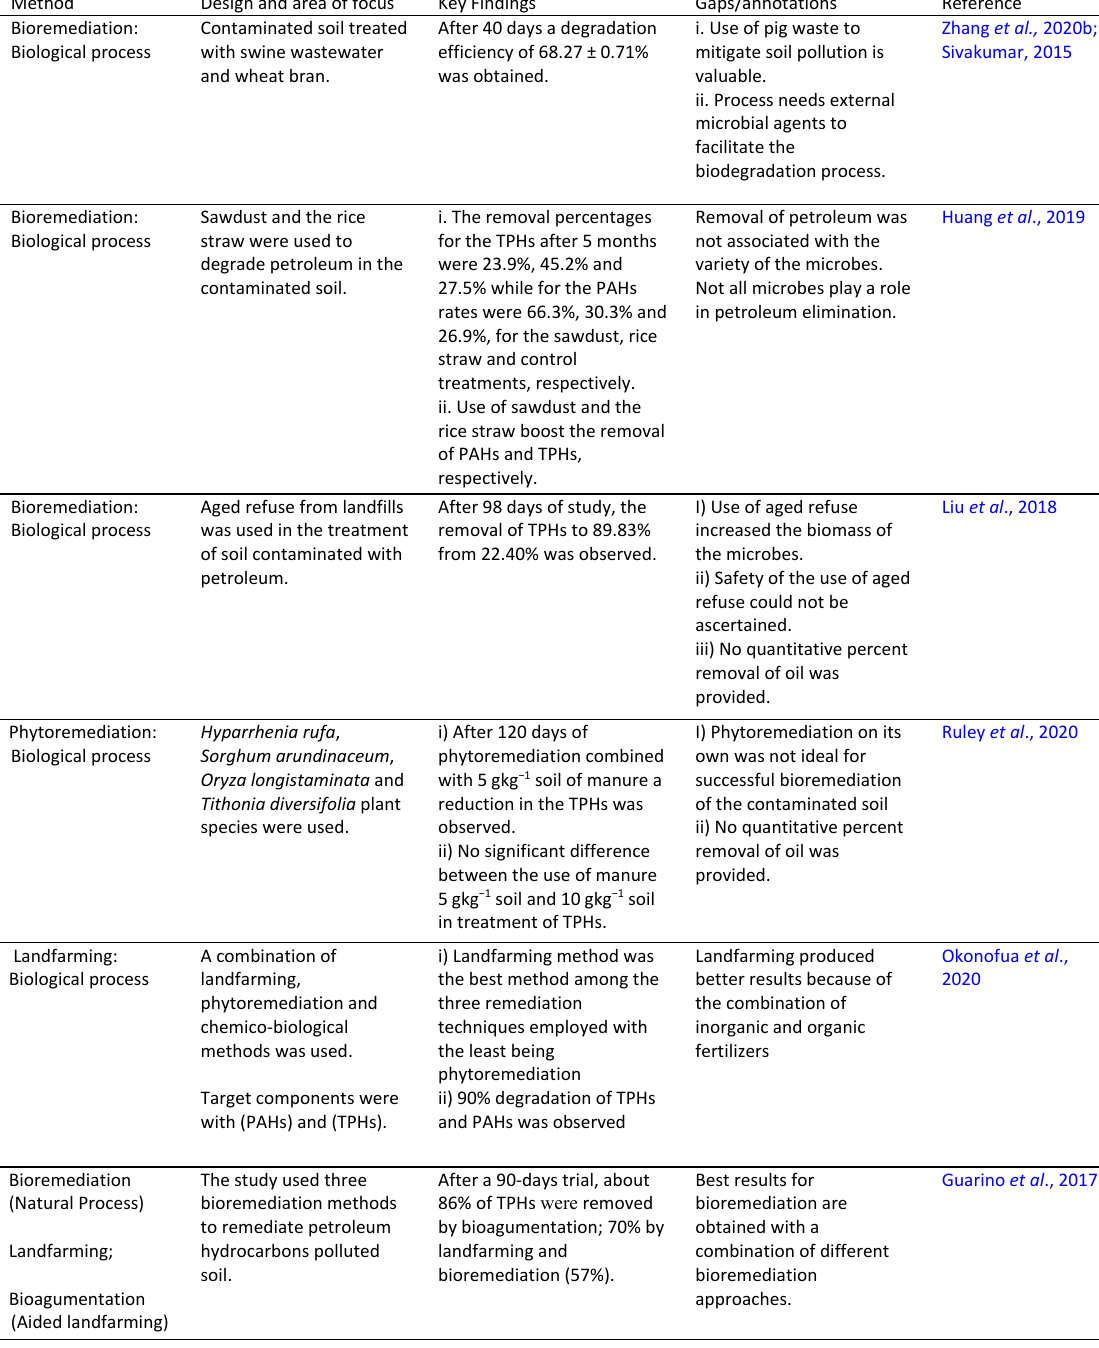
Table 2: Common biological remediation methods for processing soil contaminated with oil